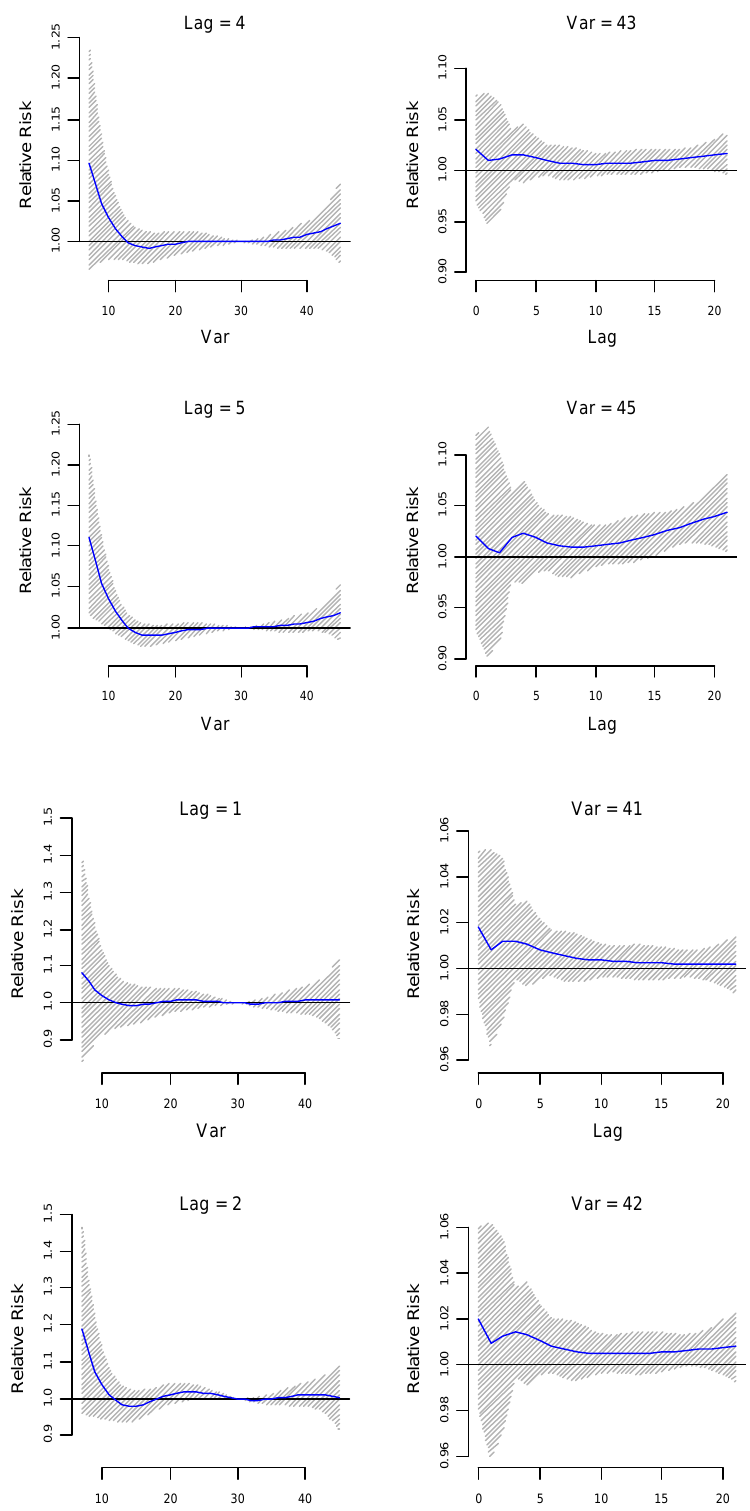
Figure 2. Lag-specific (at lags 1, 2 and 4, 5) relative risk (outcome) estimates with their 95% confidence interval plotted for different maximum temperatures. The median value of the whole temperature annual series (30 °C) is used as a reference.